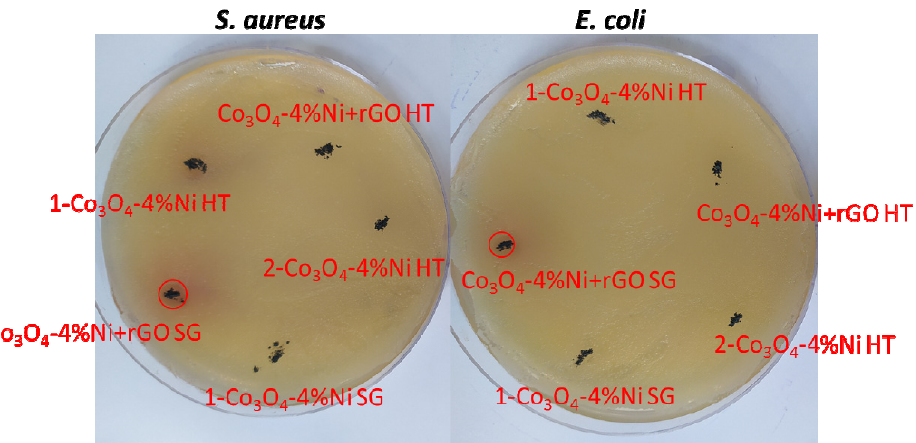
Figure 7. Co 3 O 4 samples with 4% Ni at 400 ° C; Co 3 O 4 -4%Ni+rGO SG, 1-Co 3 O 4 -4%Ni SG, 2-Co 3 O 4 - 4%Ni HT, Co 3 O 4 -4%Ni+rGO HT, 1-Co 3 O 4 -4%Ni HT. Table 2. Antimicrobial activity of Co 3 O 4 doped with Ni and addition of rGO halo inhibition (mm).